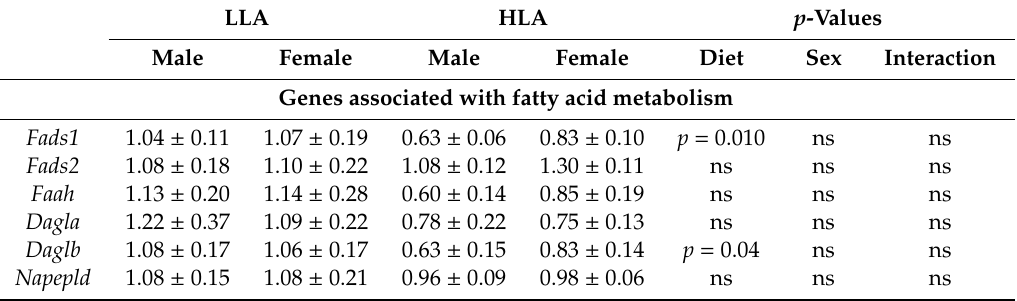
Table 2. E ff ect of a maternal diet high in linoleic acid on relative mRNA expression of genes related to fatty acid metabolism and transport in the labyrinth zone of the rat placenta. LLA HLA p